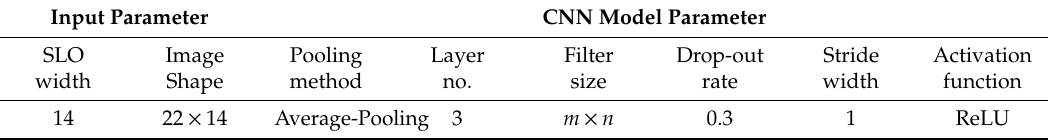
Table 1. Input parameters and hyper parameters of CNN model.